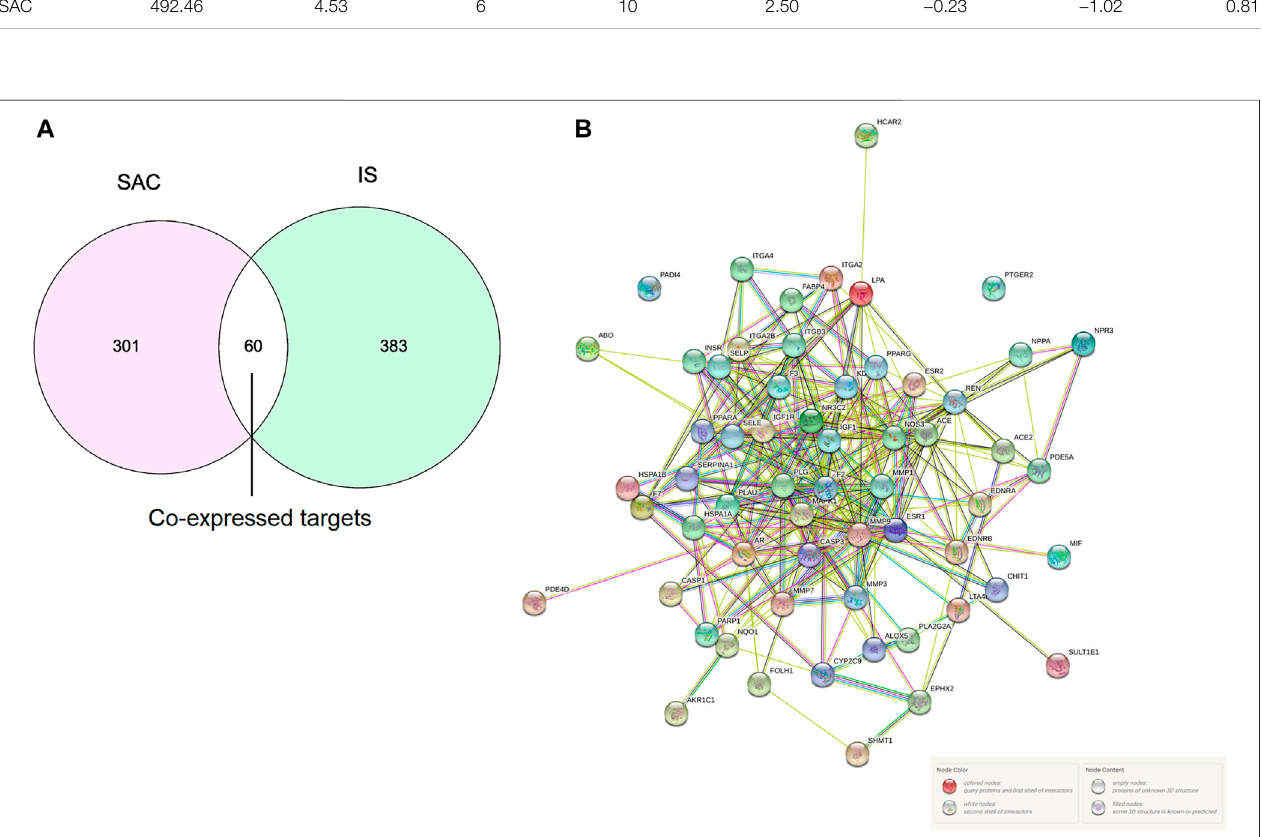
FIGURE 2 | Intersection targets of SAC and IS (A) . PPI network, Nodes represent proteins, and edges represent interactions (B) .